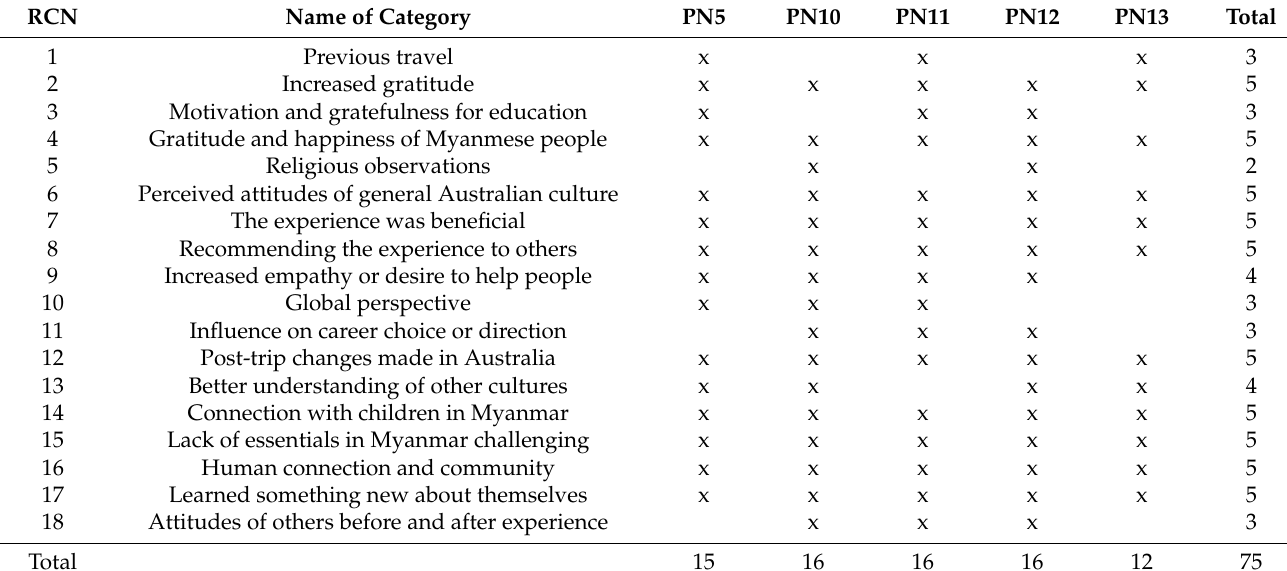
Table 2. Visual summary of qualitative coding. RCN = raw coding number; PN = participant number. RCN Name of